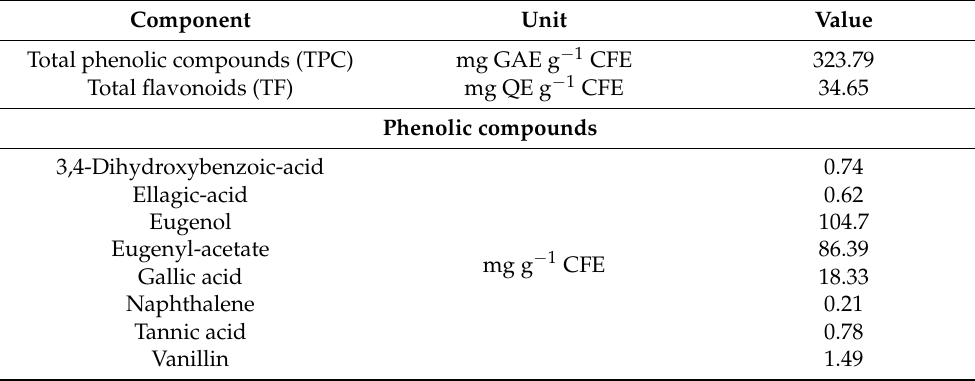
Table 2. Some chemical constituents of clove fruit extract (CFE) (on dry weight